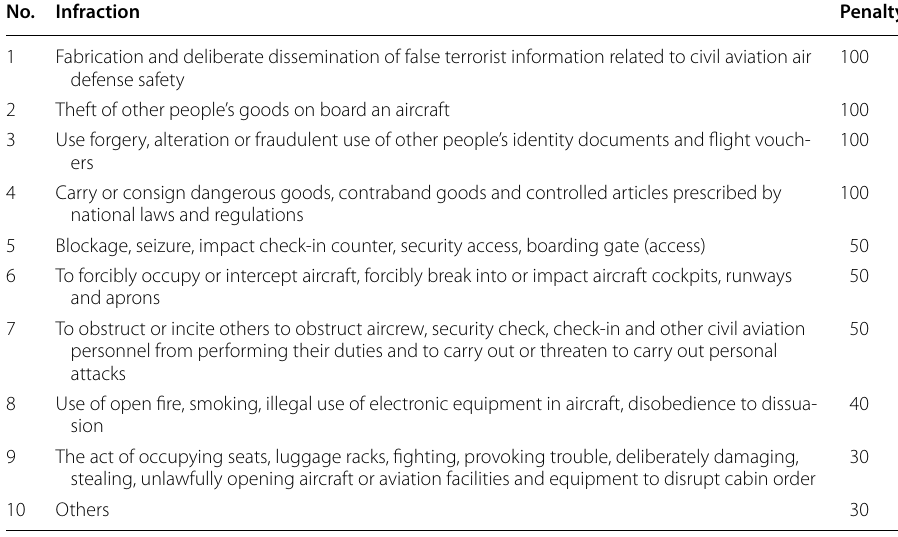
Table 7 Civil aviation passenger credit record penalty standard No.